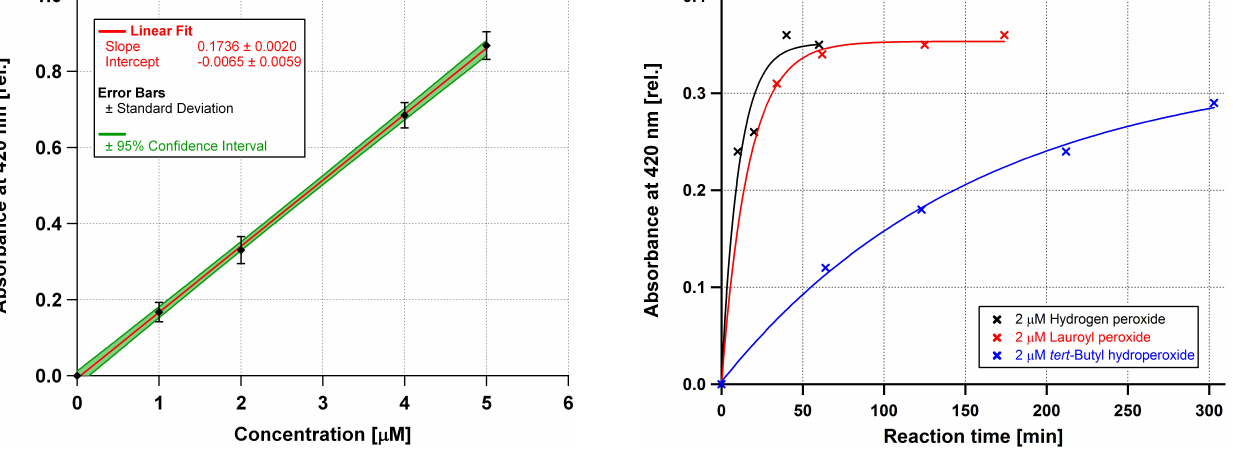
Fig. 5. Time evolution curves for the conversion of iodide ions to tri- iodide via molecular iodine (at an iodide concentration of 63mM). The diagram presents three exponential fits for 2µM solutions of hydrogen peroxide, lauroyl peroxide and tert -butyl hydroperoxide at 40 ◦ C. Background levels are